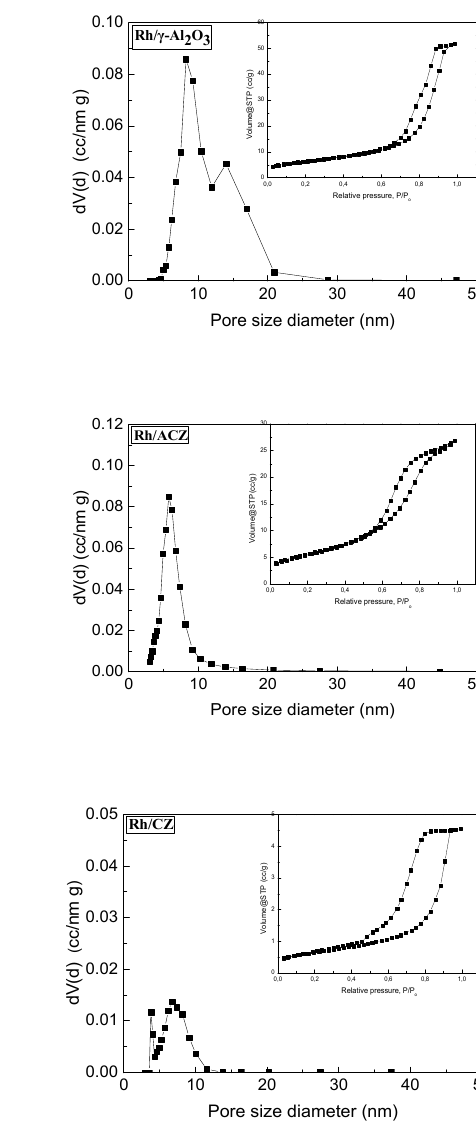
Figure 2. Pore size distribution and N 2 adsorption–desorption isotherms (inset) of the support